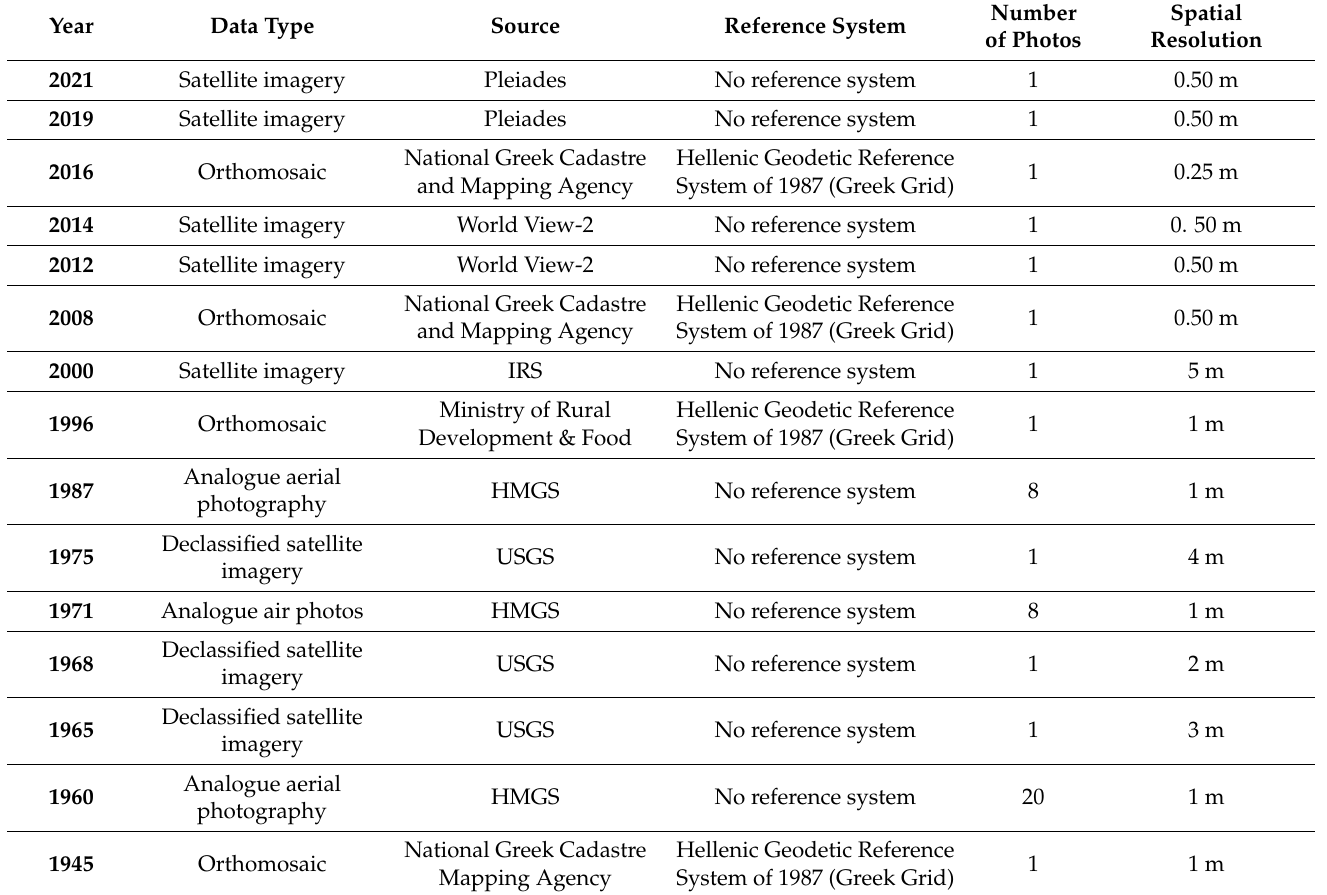
Table 1. Datasets used in the current